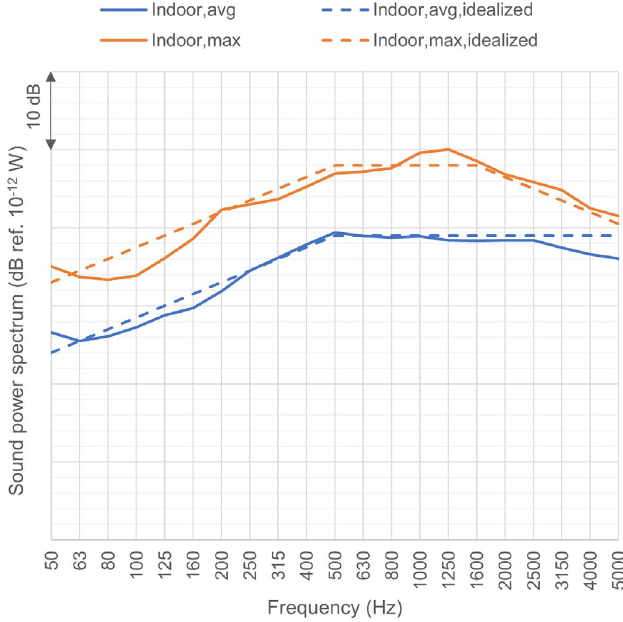
Figure 2. Proposed alternative indoor sound